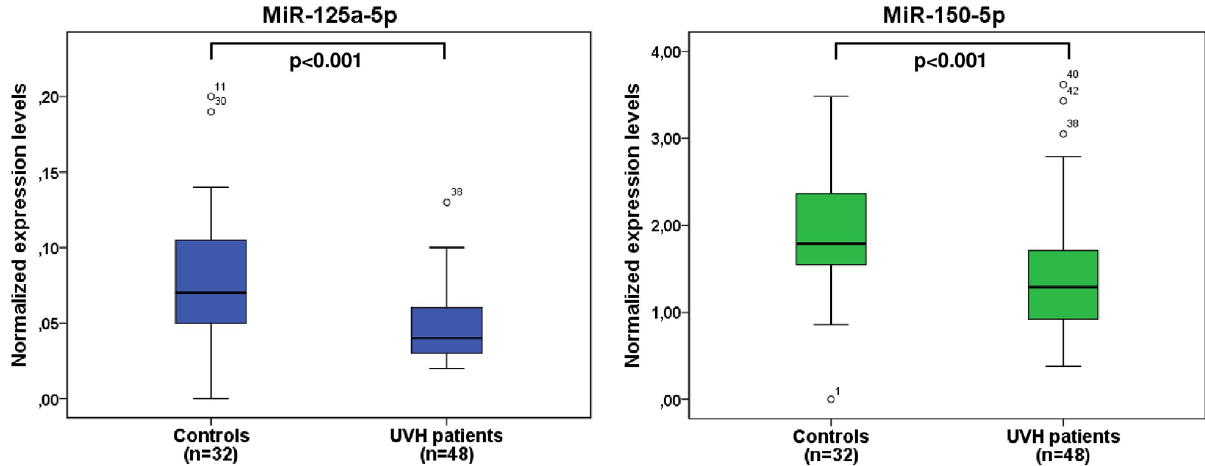
Fig 1. Boxplots displaying normalized expression levels of miR-125a-5p and miR-150-5p in patients with UVH (n = 48) compared to healthy controls (n = 32). UVH, univentricular heart.